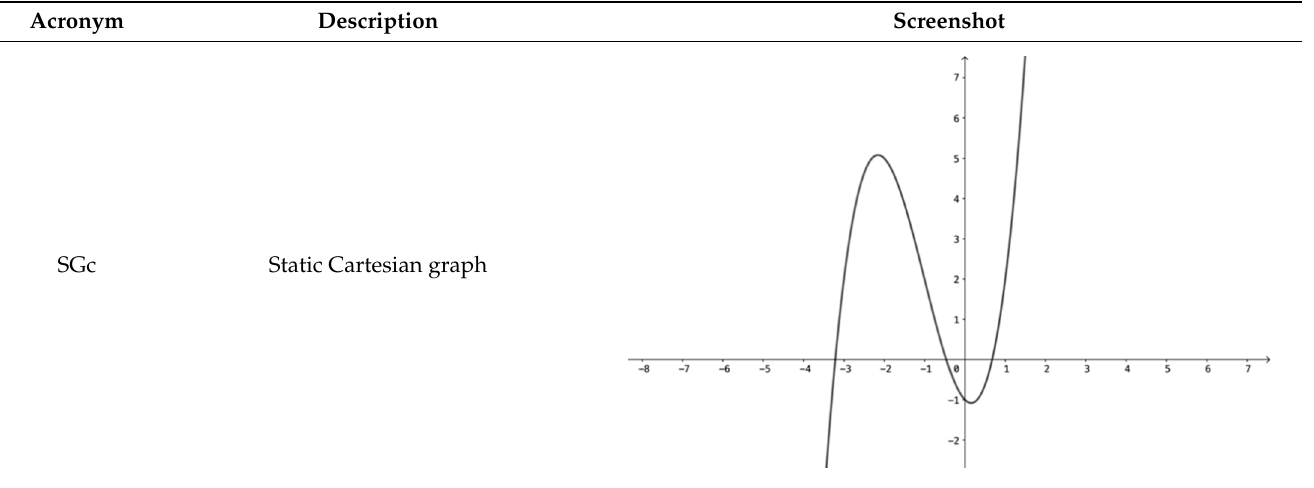
Figure 1. The process of construction of an SGc from a DGc in the DIE. ( a ) Two ticks representing x and 𝑓(𝑥) are respec- tively on the x -axis and on the y -axis. The tick that represents x can be (directly) dragged and the movement of x causes the (indirect) movement of 𝑓(𝑥) , according to the functional dependency. ( b ) The point (𝑥,𝑓(𝑥)) is built as the intersec- tion point of the perpendicular line to the x -axis passing through (𝑥, 0) and the perpendicular line to the y -axis passing through (0, 𝑓(𝑥)) . ( c ) The activation of the trace mark on (𝑥,𝑓(𝑥)) and the dragging of x allow to visualize the trajectory of (𝑥, 𝑓(𝑥)) and then the graph of the